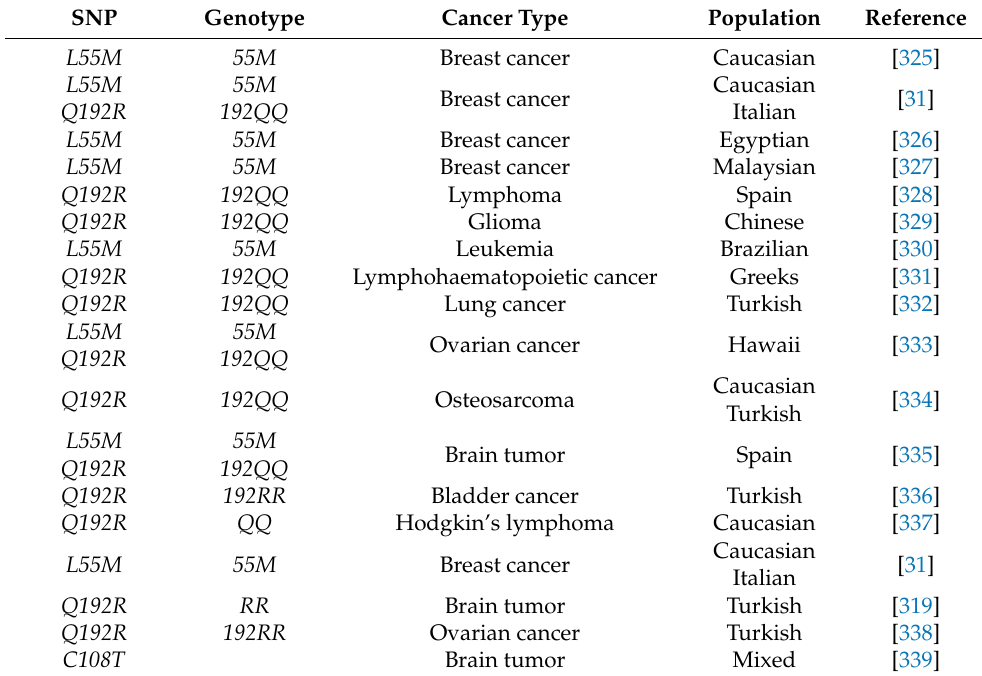
Table 5. Association between PON1 polymorphisms and cancer susceptibility. SNP